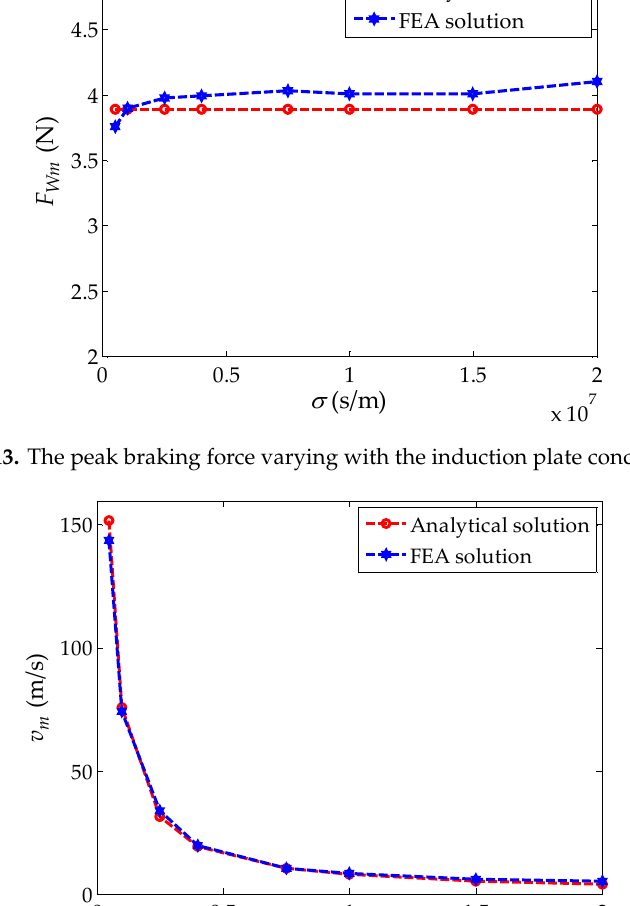
Table 3. Maximum error of the analytical solution and FEA solution.